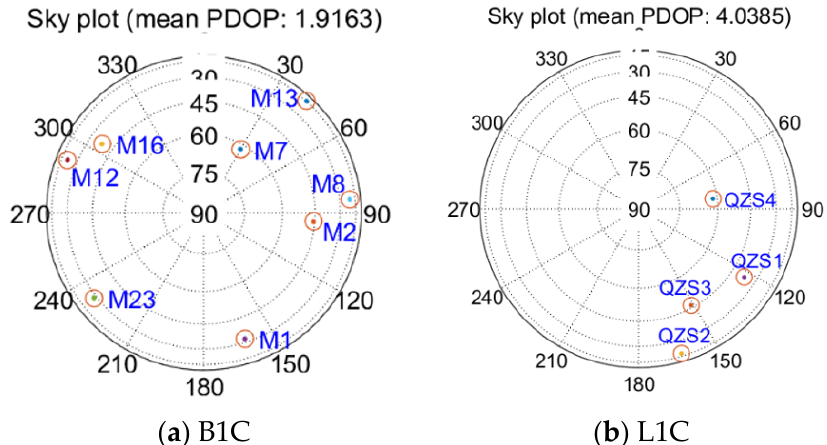
Figure 10. The Sky plot of data collected in Luo-nan at 23:31:26 on 25 January 2021.